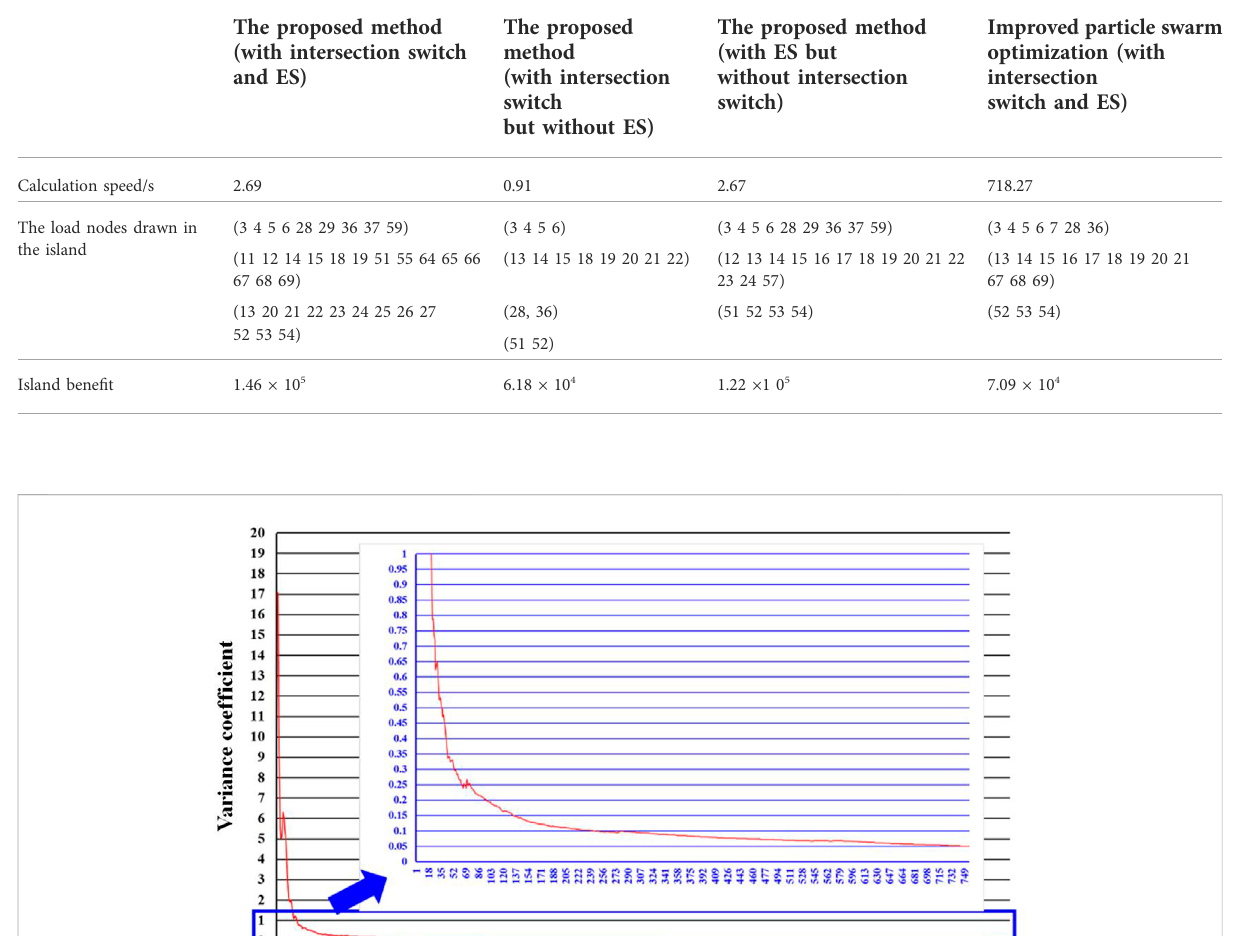
TABLE 3 The comparison of key factors on the bene fi t of island partition.